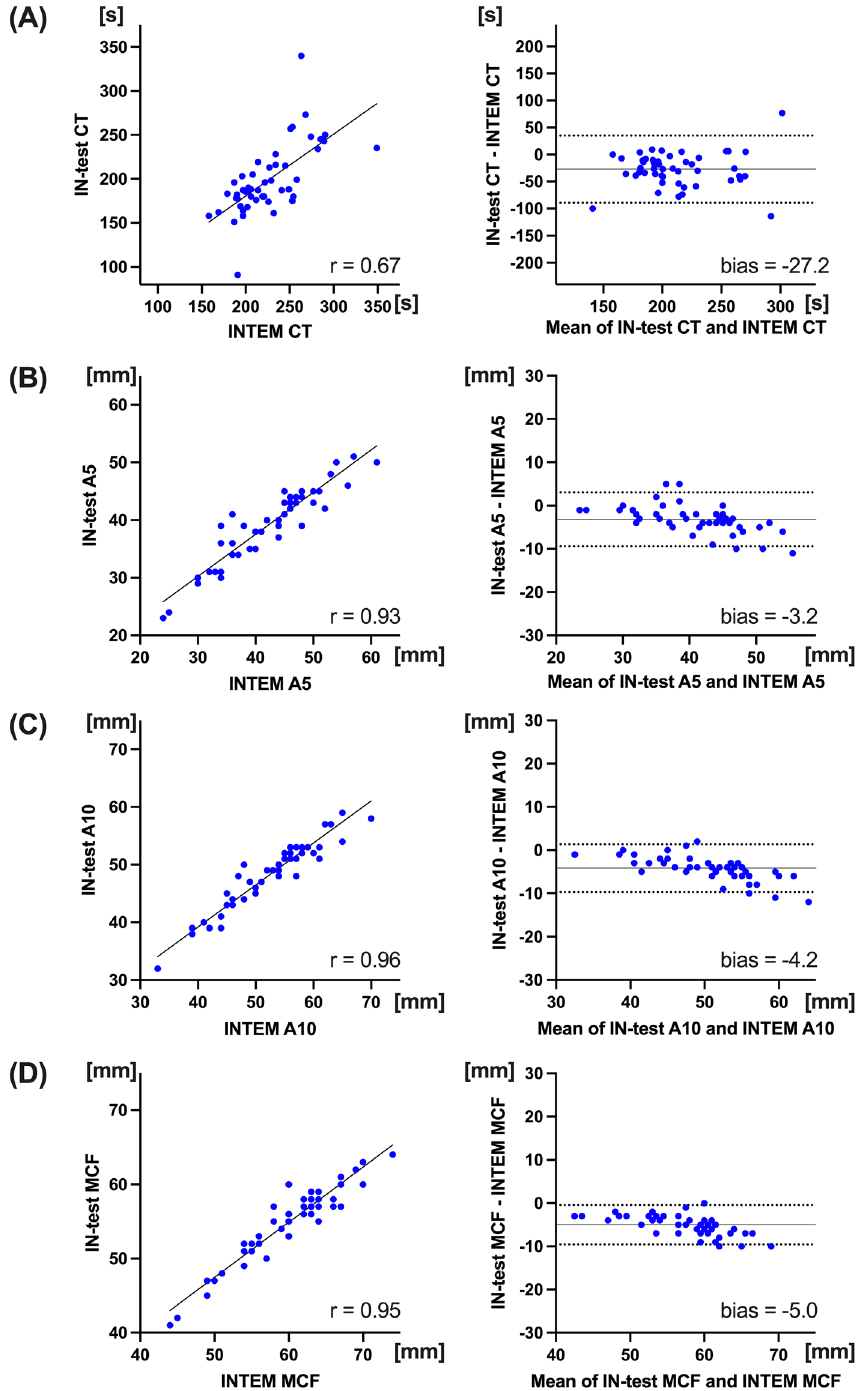
Figure 3. Relationship between IN-test and INTEM. Linear regression and Bland–Altman analysis, between IN-test CT and INTEM CT ( A ). Linear regression and Bland–Altman analysis of clot firmness, between IN-test and INTEM; A5 ( B ), A10 ( C ), and MCF ( D ). Solid line in Bland–Altman analysis depicts bias, and dotted lines depict 95% limits of agreements. CT clotting time, MCF maximum clot